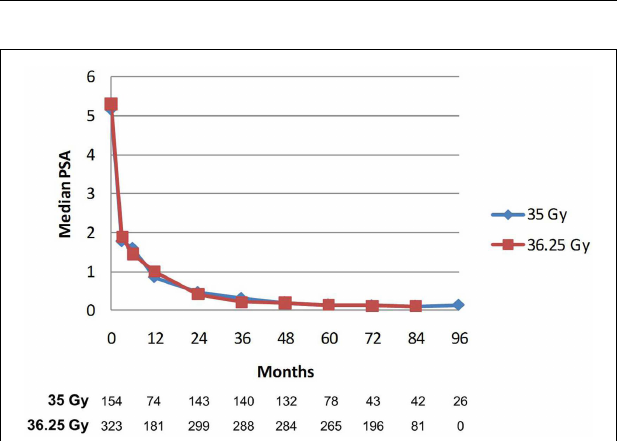
FIGURE 9 | Median PSA value stratified by dose .There was no significant difference between median PSA values for any of the data points.The Number of patients with PSA data at each time point is listed below. Patients with biochemical recurrence are excluded.